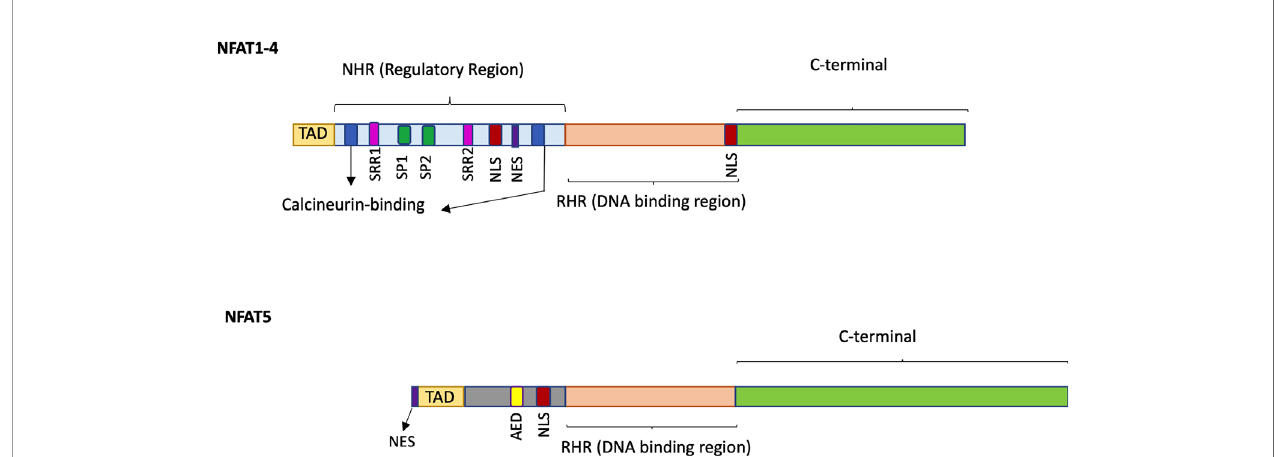
FIGURE 1 | Schematic representation of the structure of NFAT1-4 and NFAT5. NFAT proteins contain a REL homology region (RHR), the most conserved domain, which binds to DNA and is common to all fi ve NFAT family members. The NFAT homology region (NHR) is the regulatory region conserved in NFAT1-4 members but not in NFAT5 and contains two calcineurin-binding sites, serine residues (SSR, SP), a Nuclear Localization Sequence (NLS) and a Nuclear Export Signal (NES). NFAT5 does not display the calcineurin binding site but owns an auxiliary export domain (AED) and a NLS and possess a nuclear export sequence (NES) located at the fi rst 19 amino acids. All NFAT family members have a N-terminal Transactivation Domain (TAD) and a C-terminal domain which are the less conserved